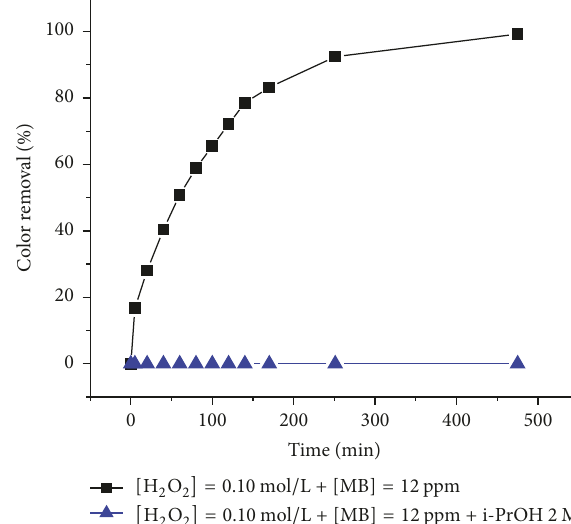
Figure 9: The X-ray diffractogram of LIB spent cathode tape before and after MB discoloration reaction (condition 3 in Table 1). Figure 10: The discoloration of 12ppm MB with 0.10 M H 2 O 2 and spent cathode with and without 2 M